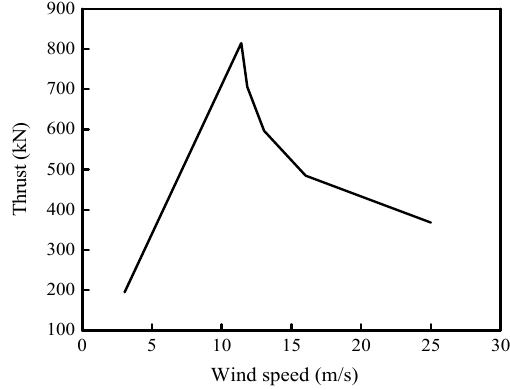
Figure 6. Diagram of the wind speed-thrust curve.